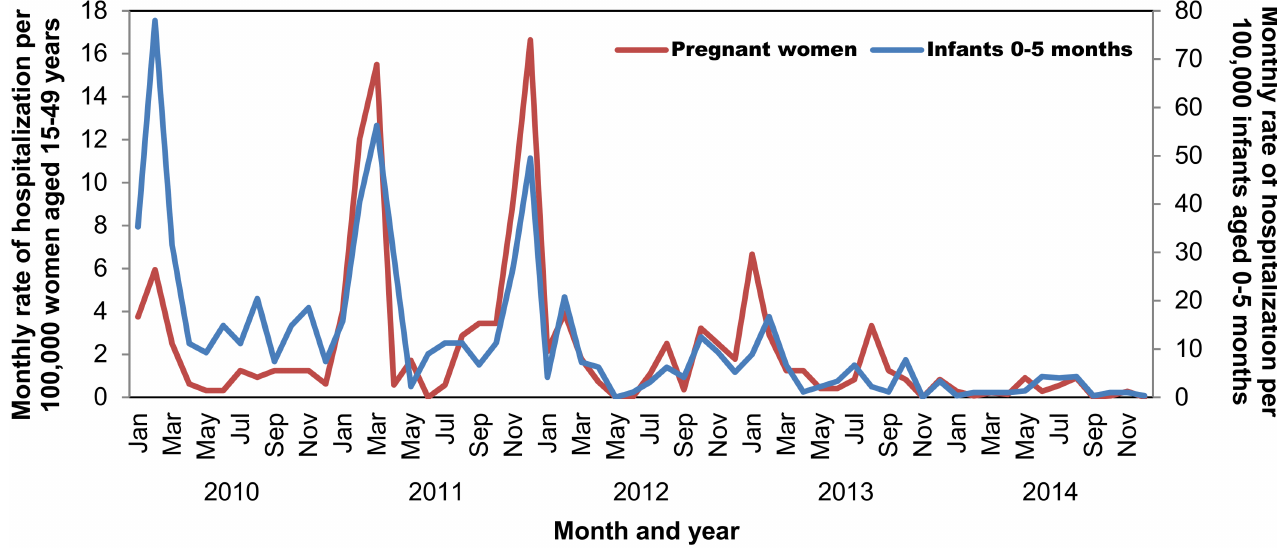
Fig 1. Monthly rate of influenza-associated hospitalization per 100,000women aged 15–49 yearsor per 100,000infants aged 0–5 months, Kenya, 2010–2014 * .